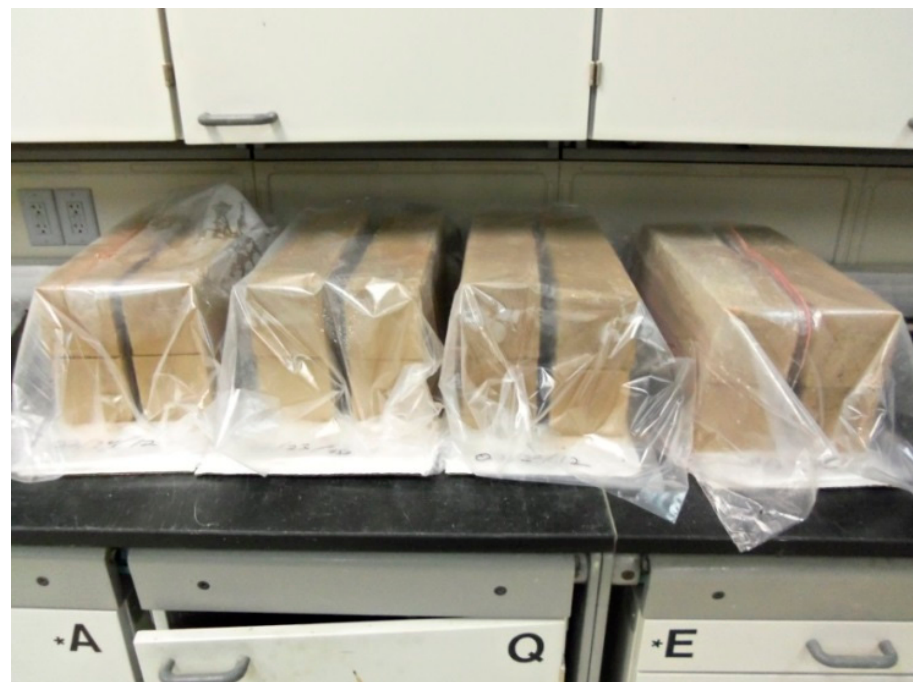
Figure 2. Initial cure of CEBs under plastic sheets.